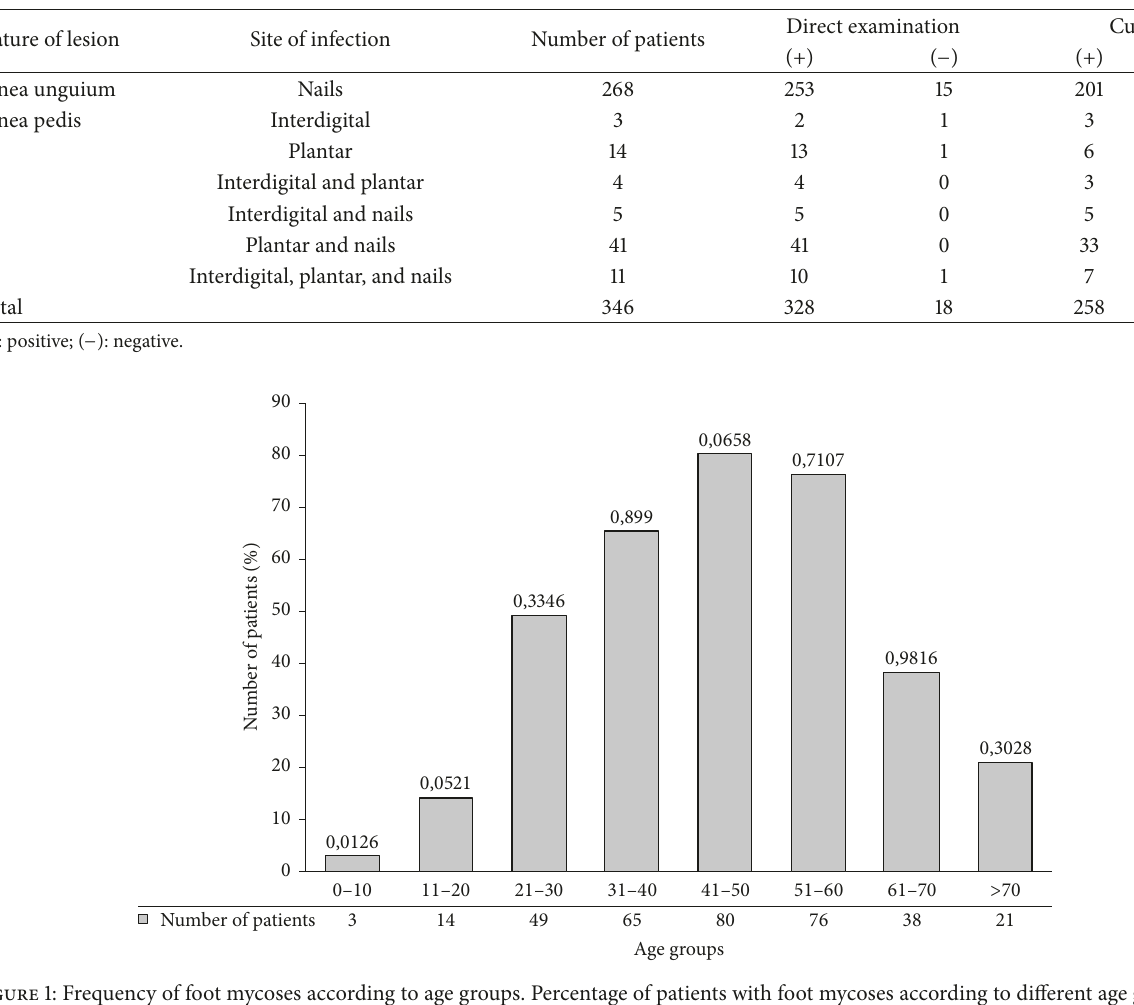
Table 2: Distribution of foot mycoses according to anatomic sites.